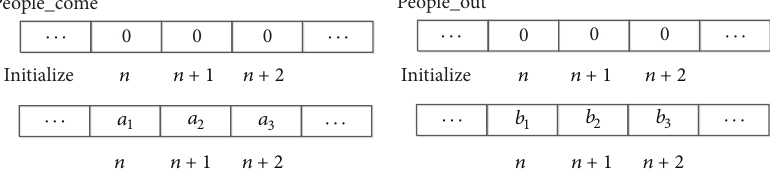
Figure 13: Initialization chart of one-dimensional cellular at the entrance and export.